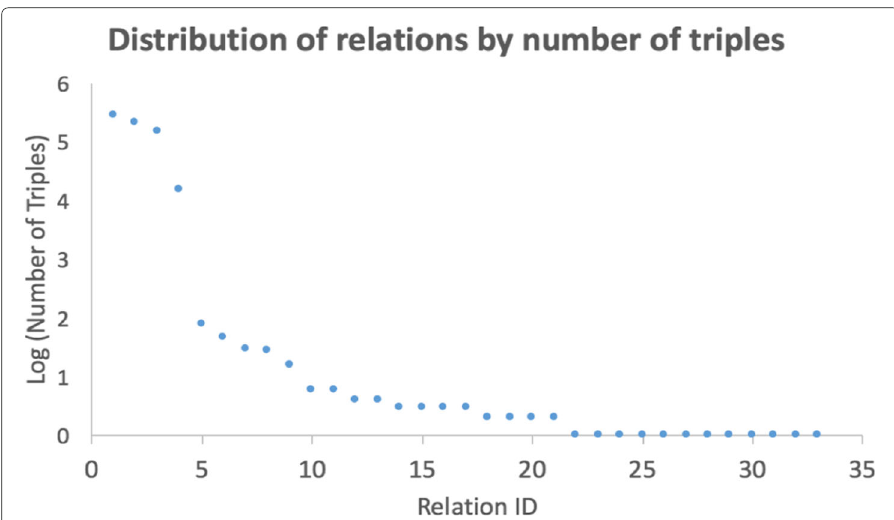
Fig. 1 Probability distributions (on a semi-log scale) of the 33 unique relations in the dataset, with IDs assigned to relations according to descending order of frequency (number of triples containing that